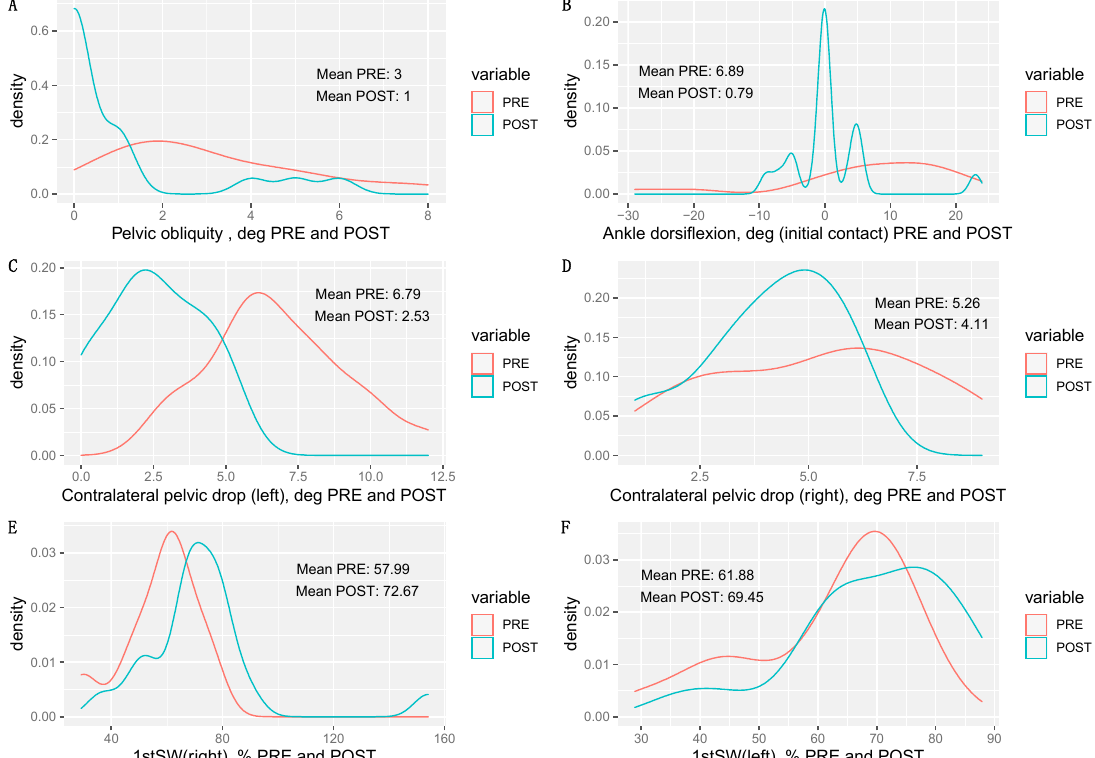
Figure 3. Density plots showing the differences between pre- and post-values obtained before and after the retraining phase . Higher density values on the ordinate axis point out which are the most probable values on the abscissa axis. The difference in pelvic obliquity in the right and left limb (A), ankle dorsiflexion in the initial contact (B), contralateral pelvic drop (C, D), and gluteus medius activation during the first phase of flight (E, F).